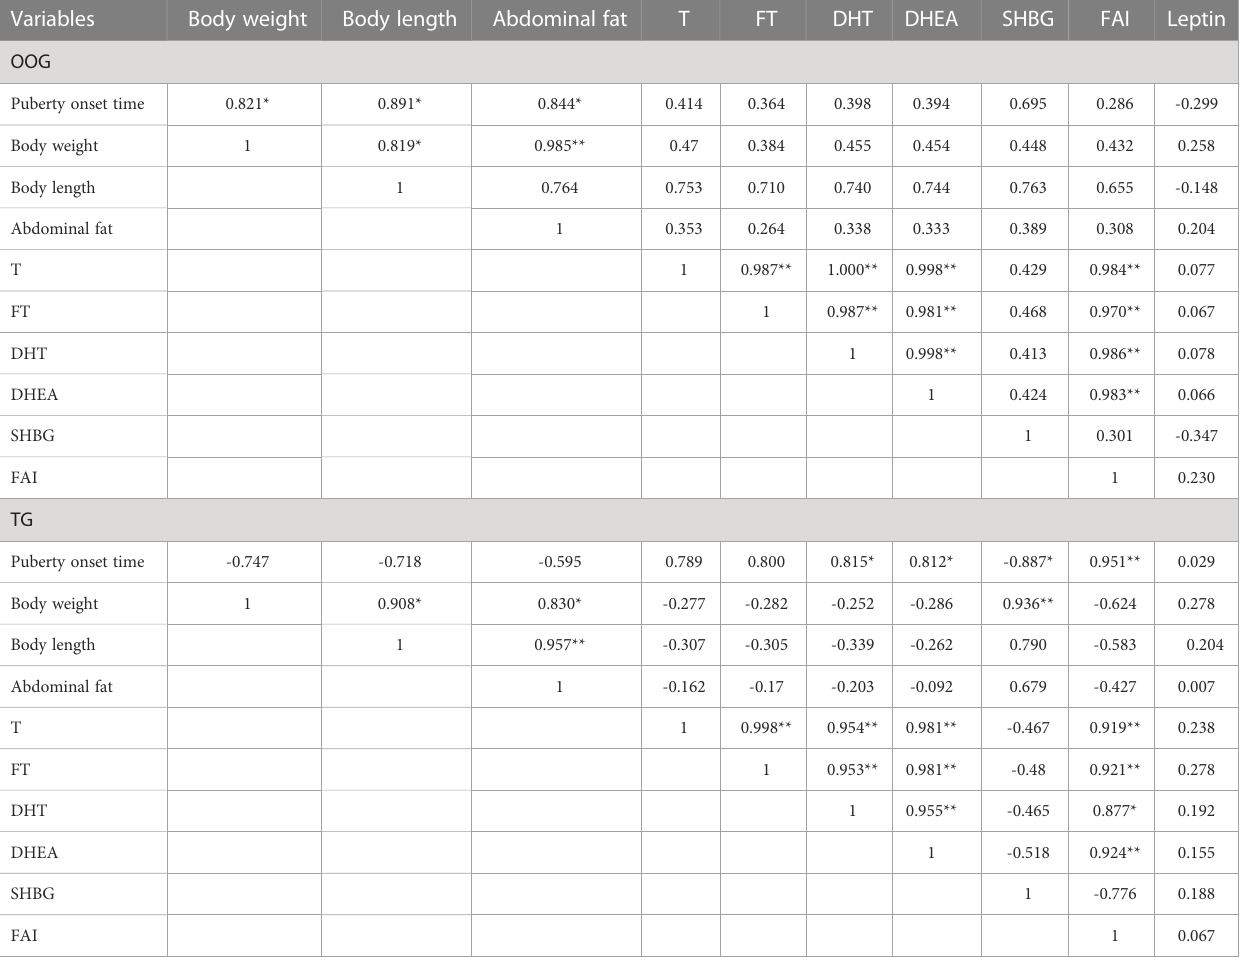
TABLE 3 Correlation between body shape indices, serum sex hormone levels and the time of onset of puberty in male offspring of OOG and TG.